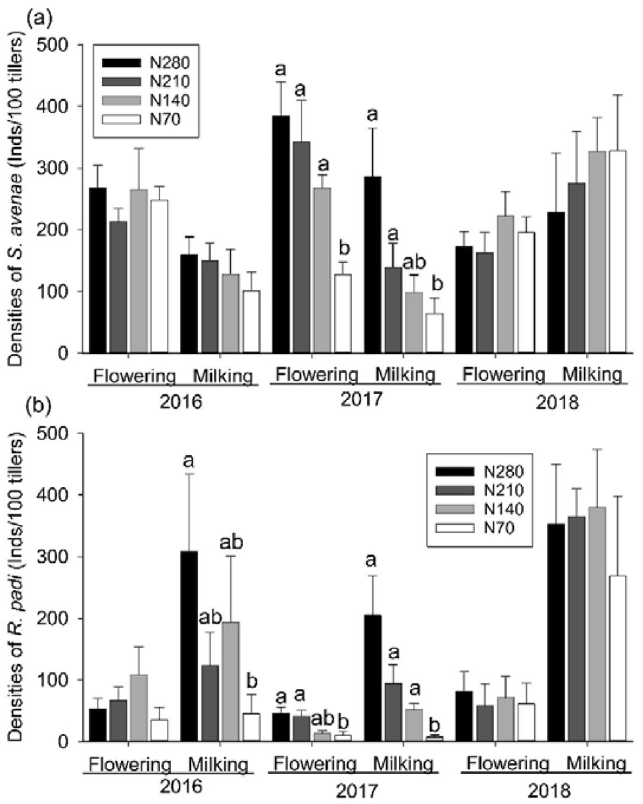
Figure 1. Densities of cereal aphids ( a : S. avenae ; b : R. padi ) (means + SE) in nitrogen fertilizer plots at the flowering and milking phases during